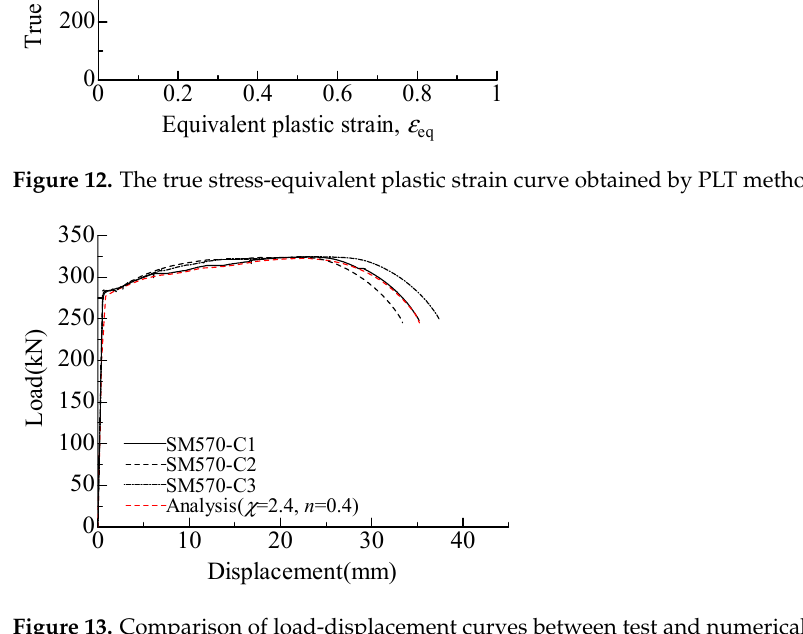
Figure 13. Comparison of load-displacement curves between test and numerical analysis.